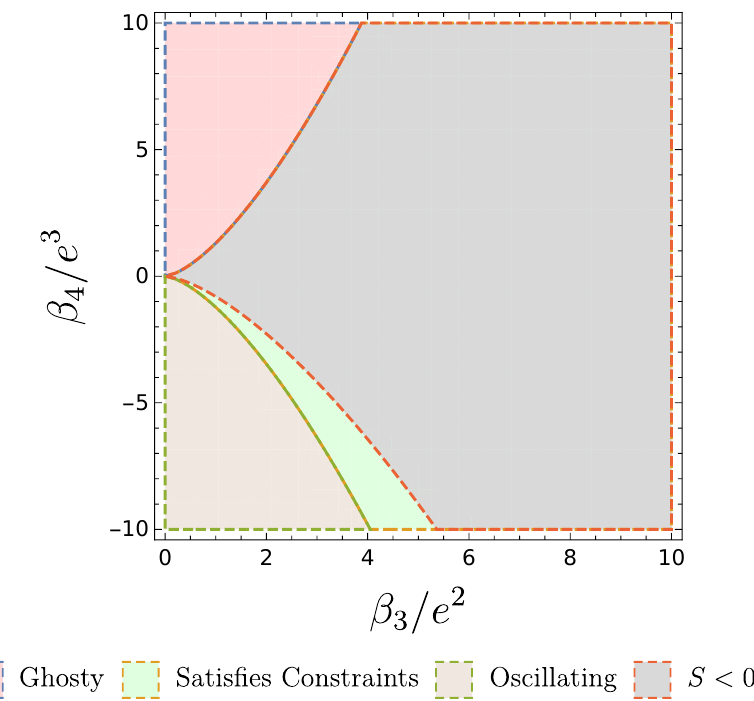
Figure 2 . Constraint pro(cid:12)les in (cid:12)ve dimensions . This plot shows a representative sampling of the parameter space, highlighting where each physicality constraint holds. The dimensionful quantities have been rescaled in terms of the electric charge parameter, e , which was then set to